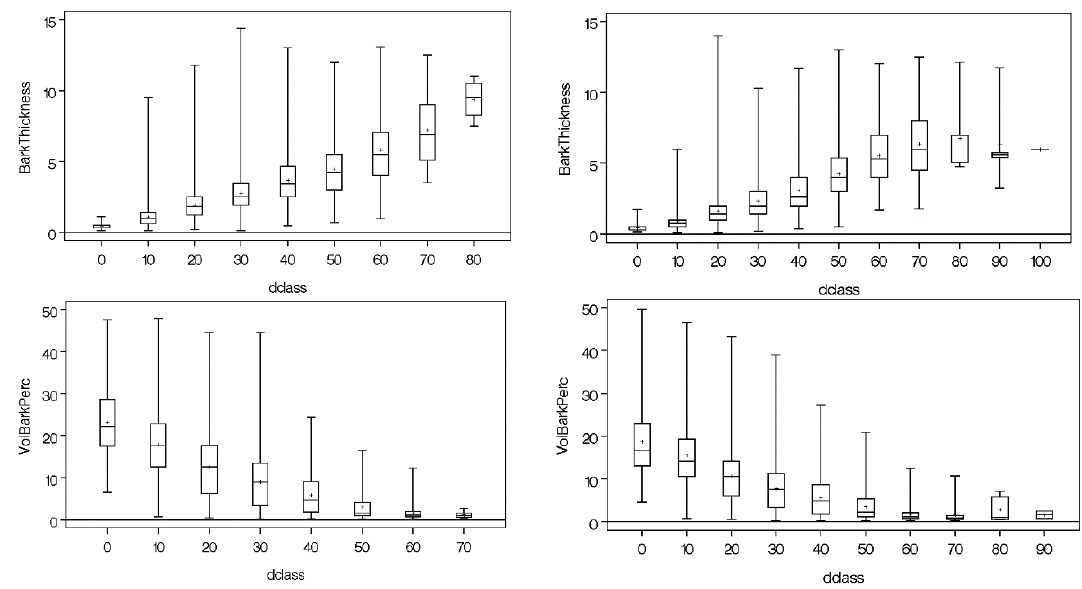
Figure 4. Observed bark thickness and percentage of bark volume for the diameter classes of the studied trees of Pinus cooperi (left figures) and Pinus durangensis (right figures). BarkThickness: thickness of bark in cm; dclass : normal diameter class (cm); VolBarkPerc : percentage of volume of bark to volume of stem under bark (%).